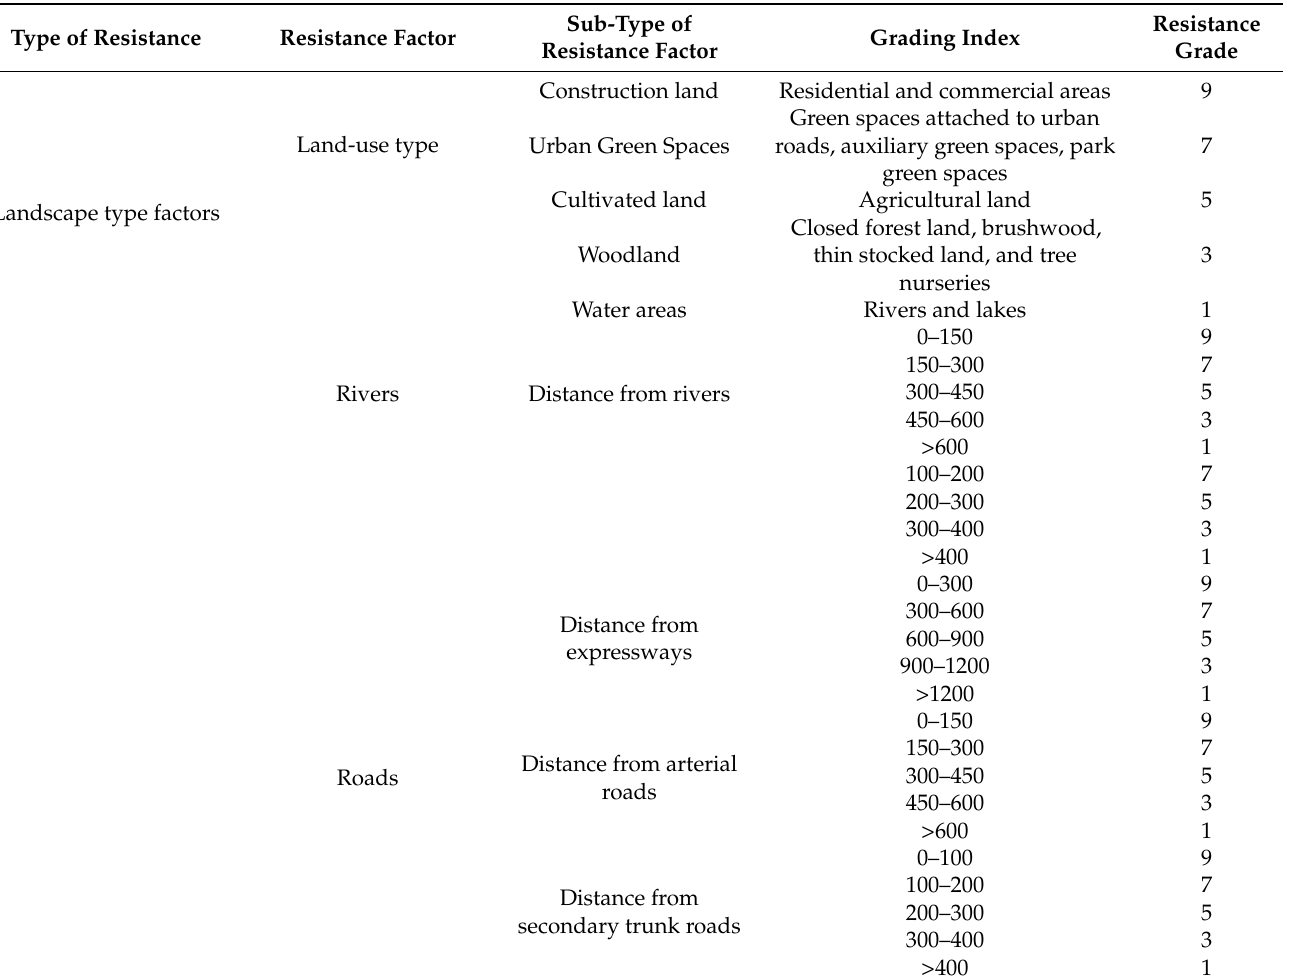
Table 2. Resistance factor and